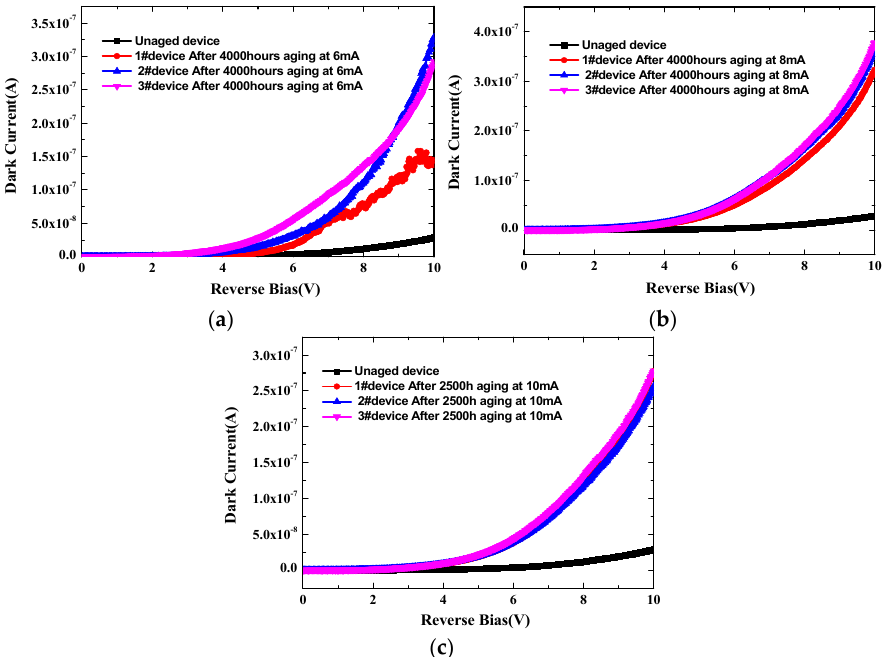
Figure 3. Reverse biased leakage current curves of the devices before and after aging at different bias currents, ( a ) 6 mA, ( b ) 8 mA and ( c ) 10